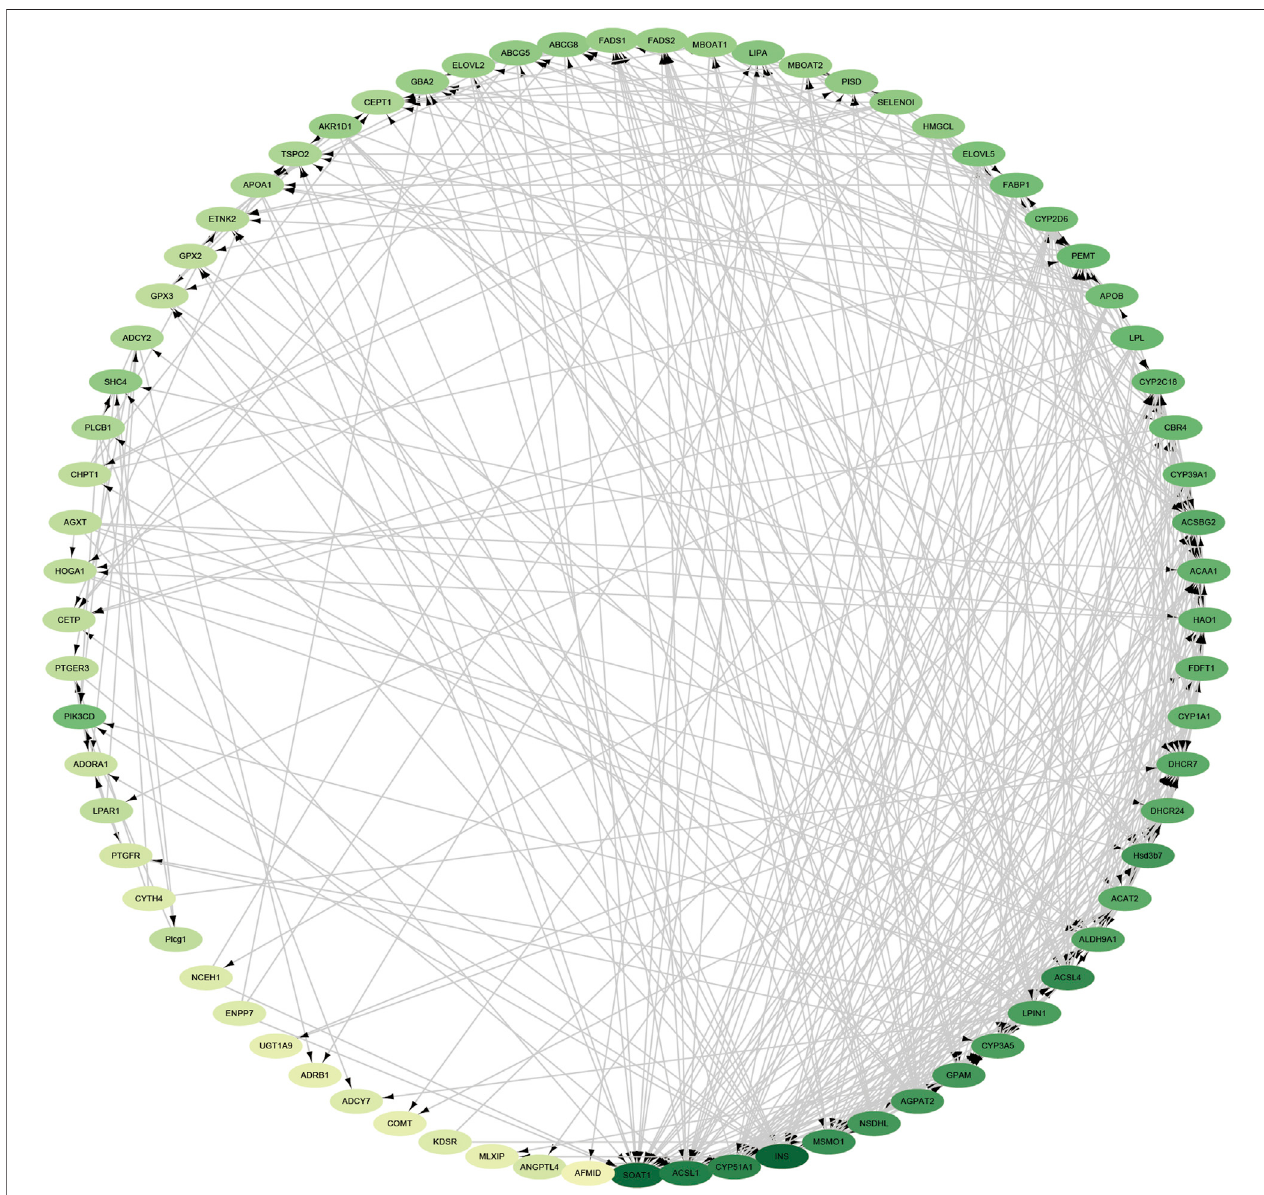
FIGURE 4 | WGCNA of genes associated with lipid metabolism. co-expression network interaction of all lipid metabolism – related genes [including genes derived from module analysis and genes in lipid metabolism-related pathways (did not require p < 0.05)], and the darker the color, the stronger the connectivity.